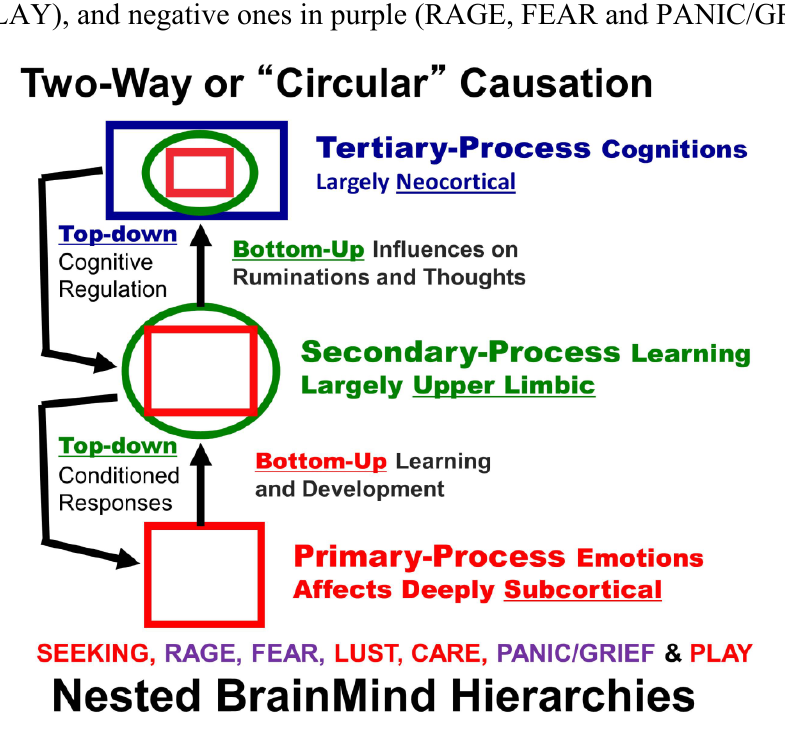
Figure 1. A schematic showing nested hierarchies of brain functions in which primary processes (red squares) influence secondary (green circles) and tertiary (blue rectangles) processes, which in turn exert top-down regulatory control. The seven primary process emotions are noted: positively valenced emotions highlighted in red (SEEKING, LUST, CARE and PLAY), and negative ones in purple (RAGE, FEAR and PANIC/GRIEF)